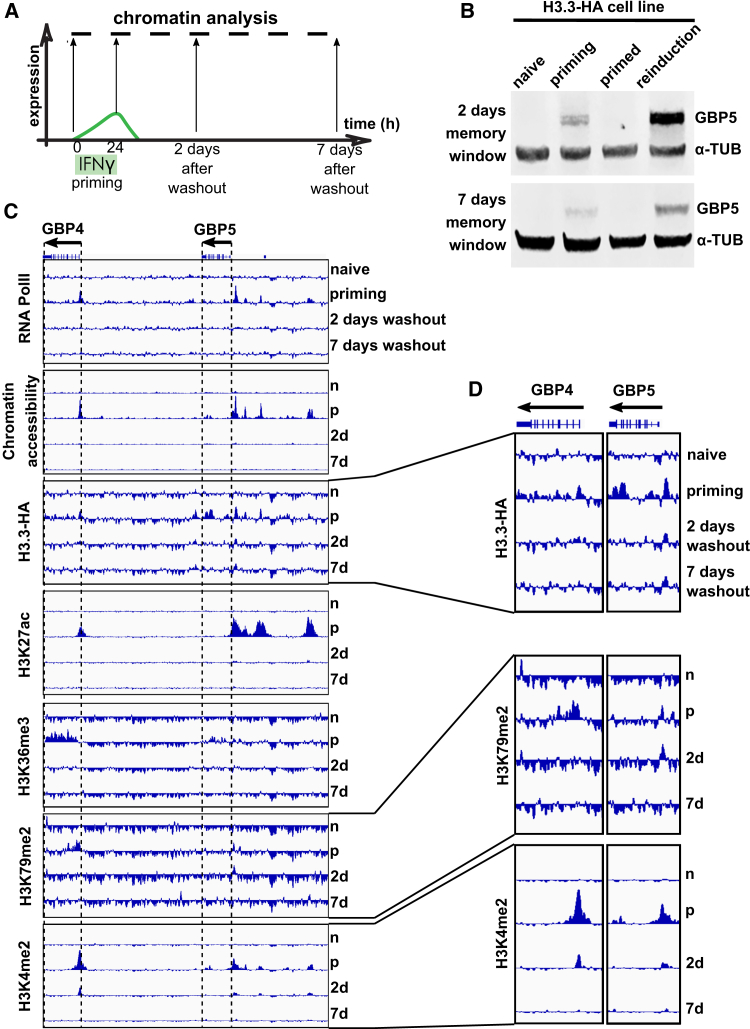
Short-Term Maintenance of H3.3, H3K4me2, and H3K79me2 on the GBP5 and GBP4 Genes following IFNγ Priming(A) Outline of the experiment to measure chromatin status following IFNγ-mediated priming.(B) HeLa cells ectopically expressing H3.3-SNAP-HA were subjected to the IFNγ treatment regimen outlined in Figure 1B with a 2- and 7-day window of memory, processed for western blotting, and probed for GBP5 protein expression. α-TUB, loading control.(C) Representation of data for processed chromatin accessibility (ATAC-seq) and occupancy of the indicated chromatin-associated factors (ChIPmentation) for the time points indicated in (A). Sequenced reads were mapped to the human genome (hg38), and coverage data are displayed with internal scaling between naive, primed, 2- and 7-day IFNγ washout samples. Two proximally positioned memory genes, GBP4 and GBP5, are shown.(D) Enlarged presentation of the GBP4 and GBP5 genes.